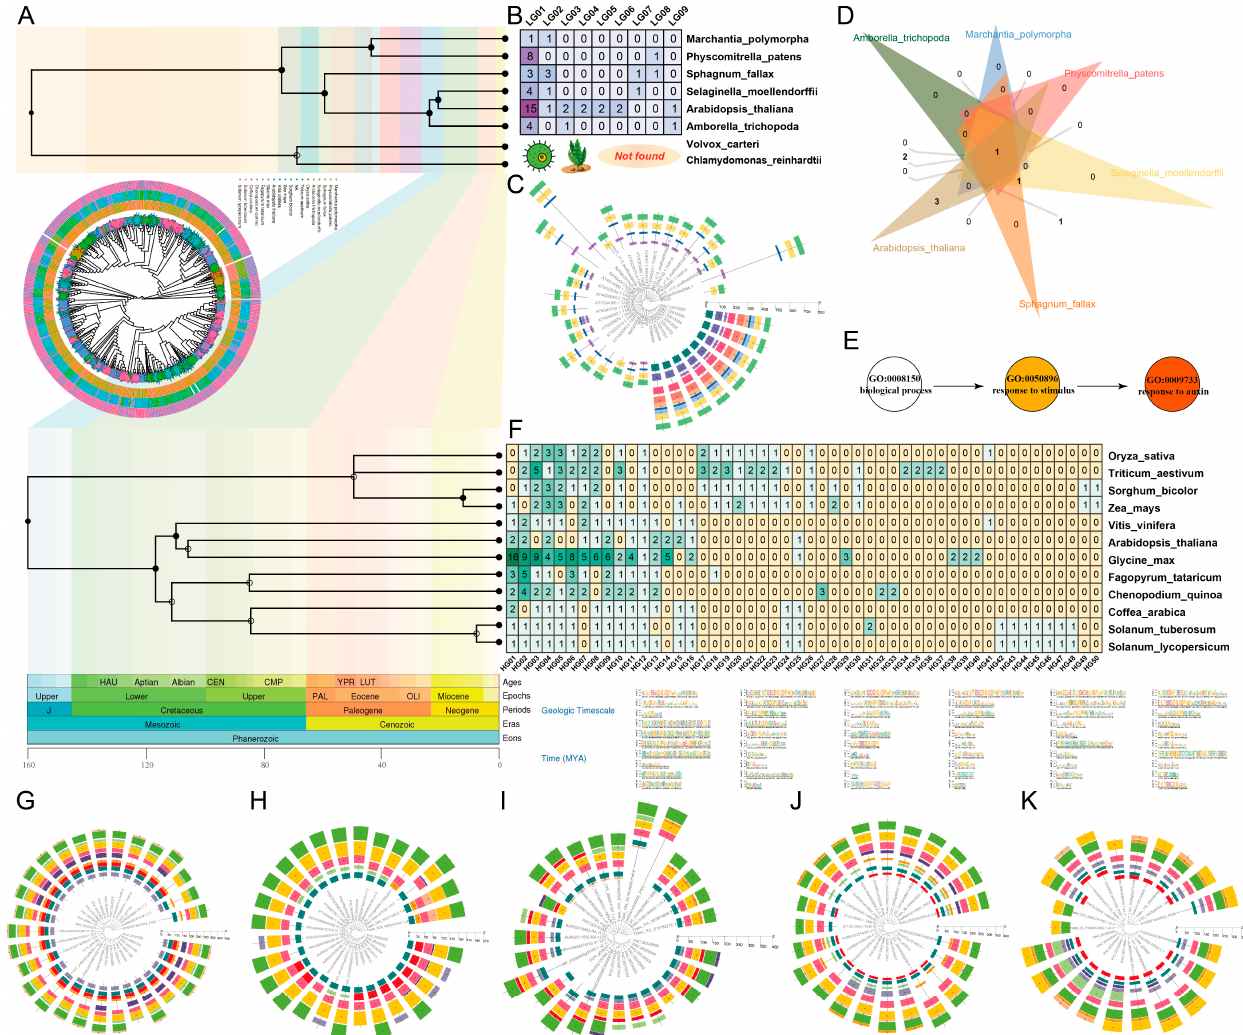
Figure 1. Phylogeny, diversity, and motif compositions of AUX/IAA proteins in 19 species. ( A ). Phylogenetic tree of 495 AUX/IAA from 19 species and their amino acid length, isoelectric point, and molecular weight. Different color blocks at the end represent the species to which the protein belongs, and the internal and external heat maps represent the amino acid length, isoelectric point, and molecular weight, respectively. The specific data are listed in the Table S1; ( B ). AUX/IAA protein orthogroups of lower plants and Arabidopsis; ( C ). Phylogenetic tree and motif structure in orthogroups group 01 (LG01) shared by lower plants; ( D , E ). Sharing of orthogroups among lower plants and GO enrichment analysis of all proteins in LG01; ( F ). AUX/IAA protein orthogroups of higher plants; ( G – K ). Phylogenetic tree and motif structure of AUX/IAA protein in HG01-HG05 middle and higher plants.